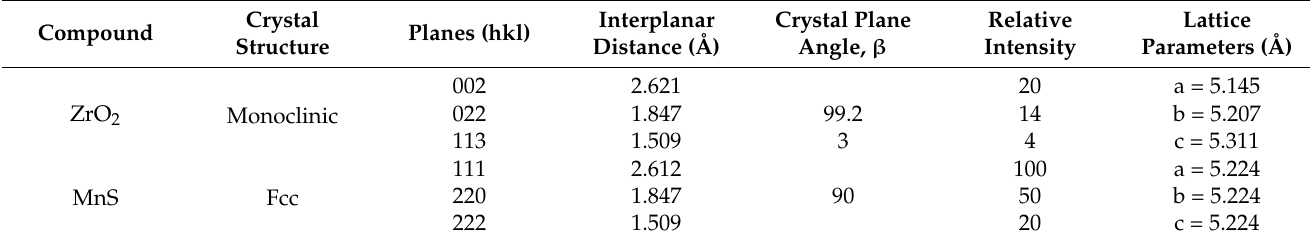
Table 4. Lattice parameters and interplanar distances for ZrO 2 and MnS (ASTM).